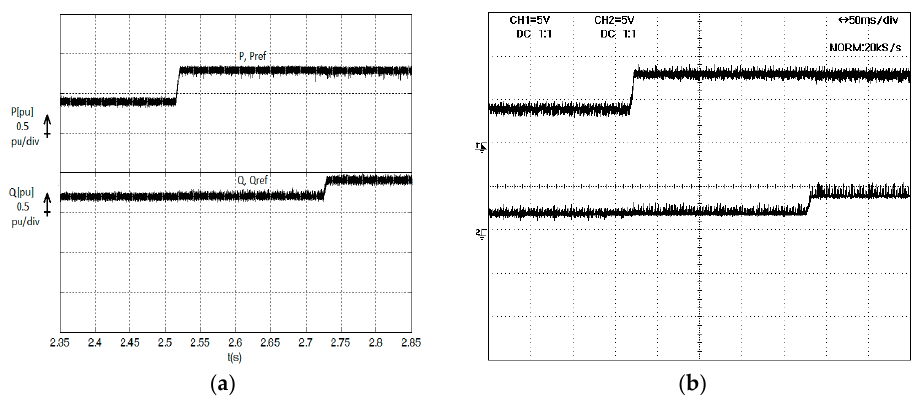
Figure 6. Active and reactive series power response for P and Q steps (first ∆ P Ref = +0.4 pu and after ∆ Q Ref = +0.2 pu). ( a ) Simulation results; ( b ) Experimental results (Ch1 = Ch2 = 0.5 pu/div).